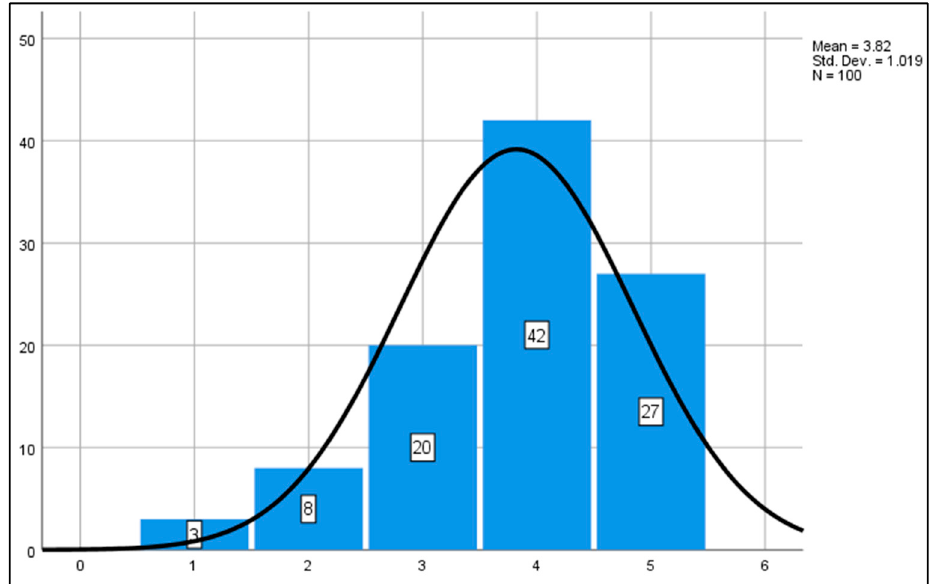
Figure 7 . Market pressure and Industry 4.0